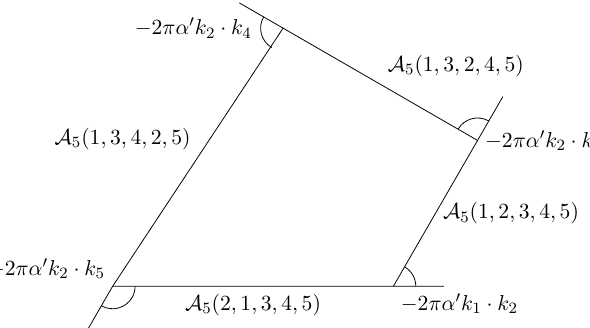
Figure 7. An example of Plahte diagrams for 5-point tachyonic